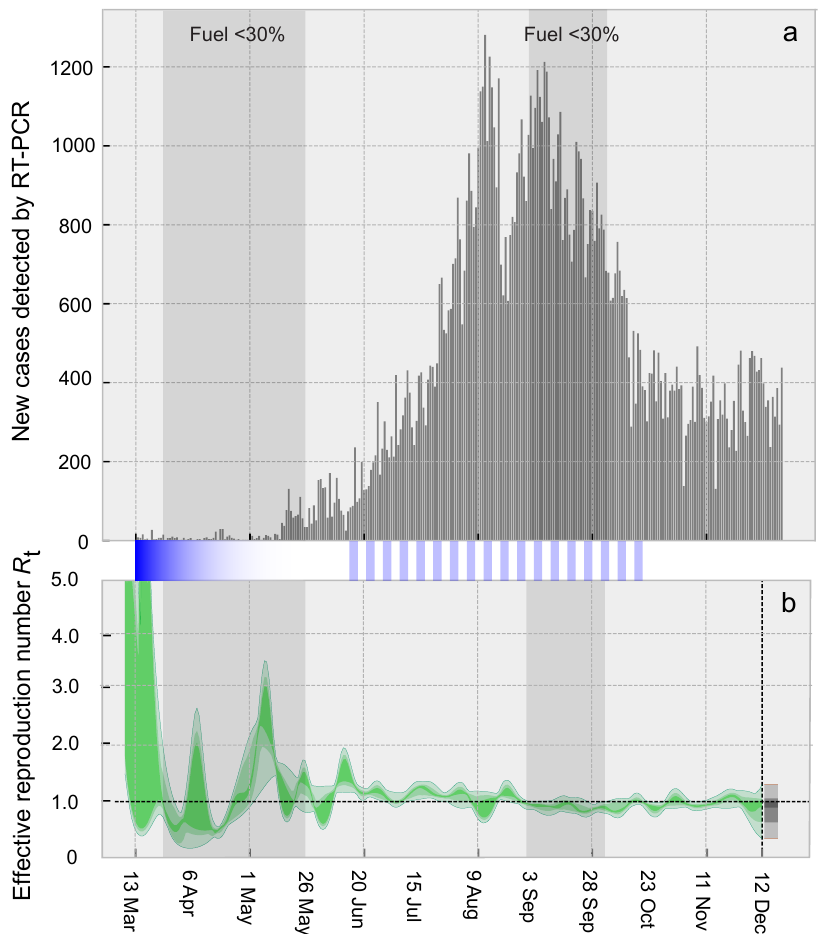
Figure 1. ( a ) Official record of daily infections in Venezuela detected by RT-PCR between 13 March and 21 December and ( b ) effective reproductive numbers estimated (green) and projected (gray) from incidence data adjusted for positivity (Figure A2), with a seven-day sliding window using the EpiNow2 package [9]. Dark, intermediate and light colored curves correspond to 50%, 90% and 95% percent confidence intervals. Dark grey windows show the periods during which less than 30% of stations had no gasoline. Blue bands indicate when stay-at-home orders were in place, and the color transparency the approximate level of